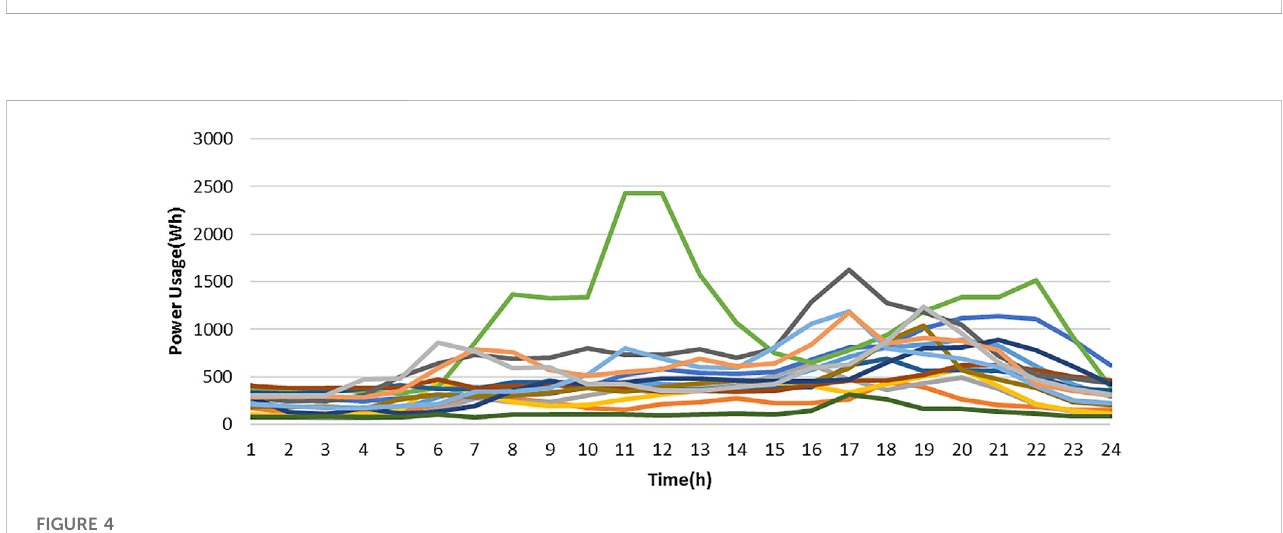
FIGURE 4 Power usage types.